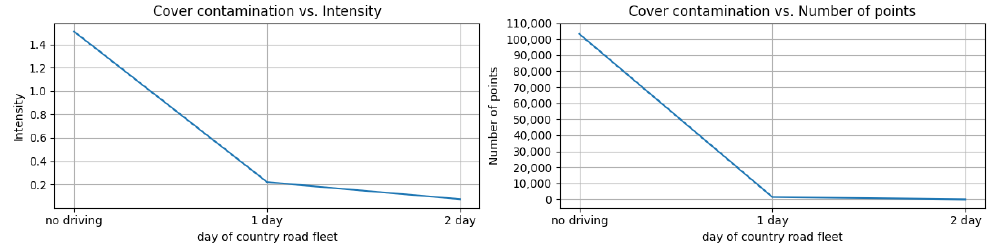
Figure 12. ( Left ) mean intensity of captured points from a reference target ( Right ) number of captured points from a reference target. For each graph the x -axis indicates the contamination condition captured by an off-road fleet in Nevada.